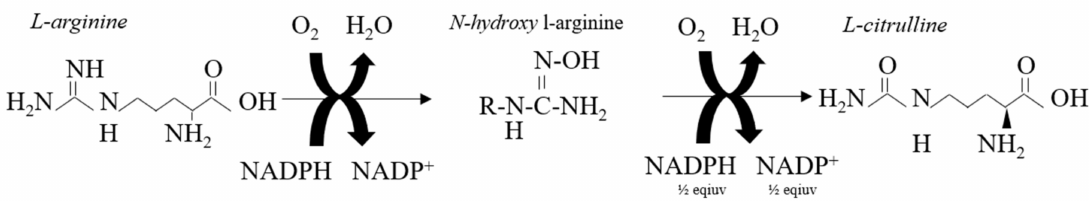
Figure 1. Biochemical formation of nitric oxide in the endothelium. NADPH = Nicotinamide adenine dinucleotide binding domain. NO = nitric oxide. O 2 = Oxygen. Equiv = Equivalent. H = hydrogen. C = Carbon. N = Nitrogen. Modified from McAllister & Laughlin 2006 [5]. ‘Vascular nitric oxide: e ff ects of physical activity, importance for health’. Essays Biochemistry vol 42. Figure 2. https: // www.ncbi.nlm.nih.gov / pubmed /